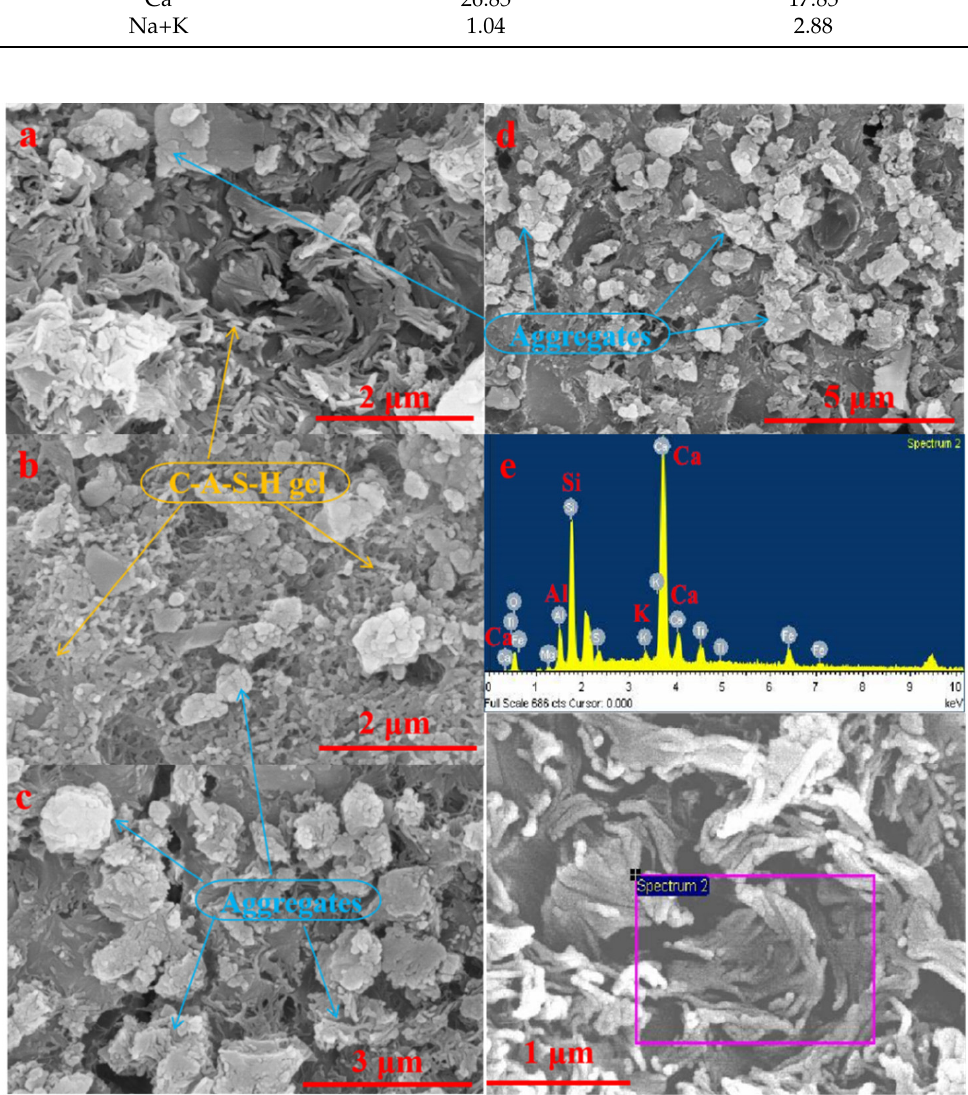
Figure 5. SEM morphology ( a – d ) and EDS analysis ( e ) of C-A-S-H gels in the AACM after 7 days of hydration.